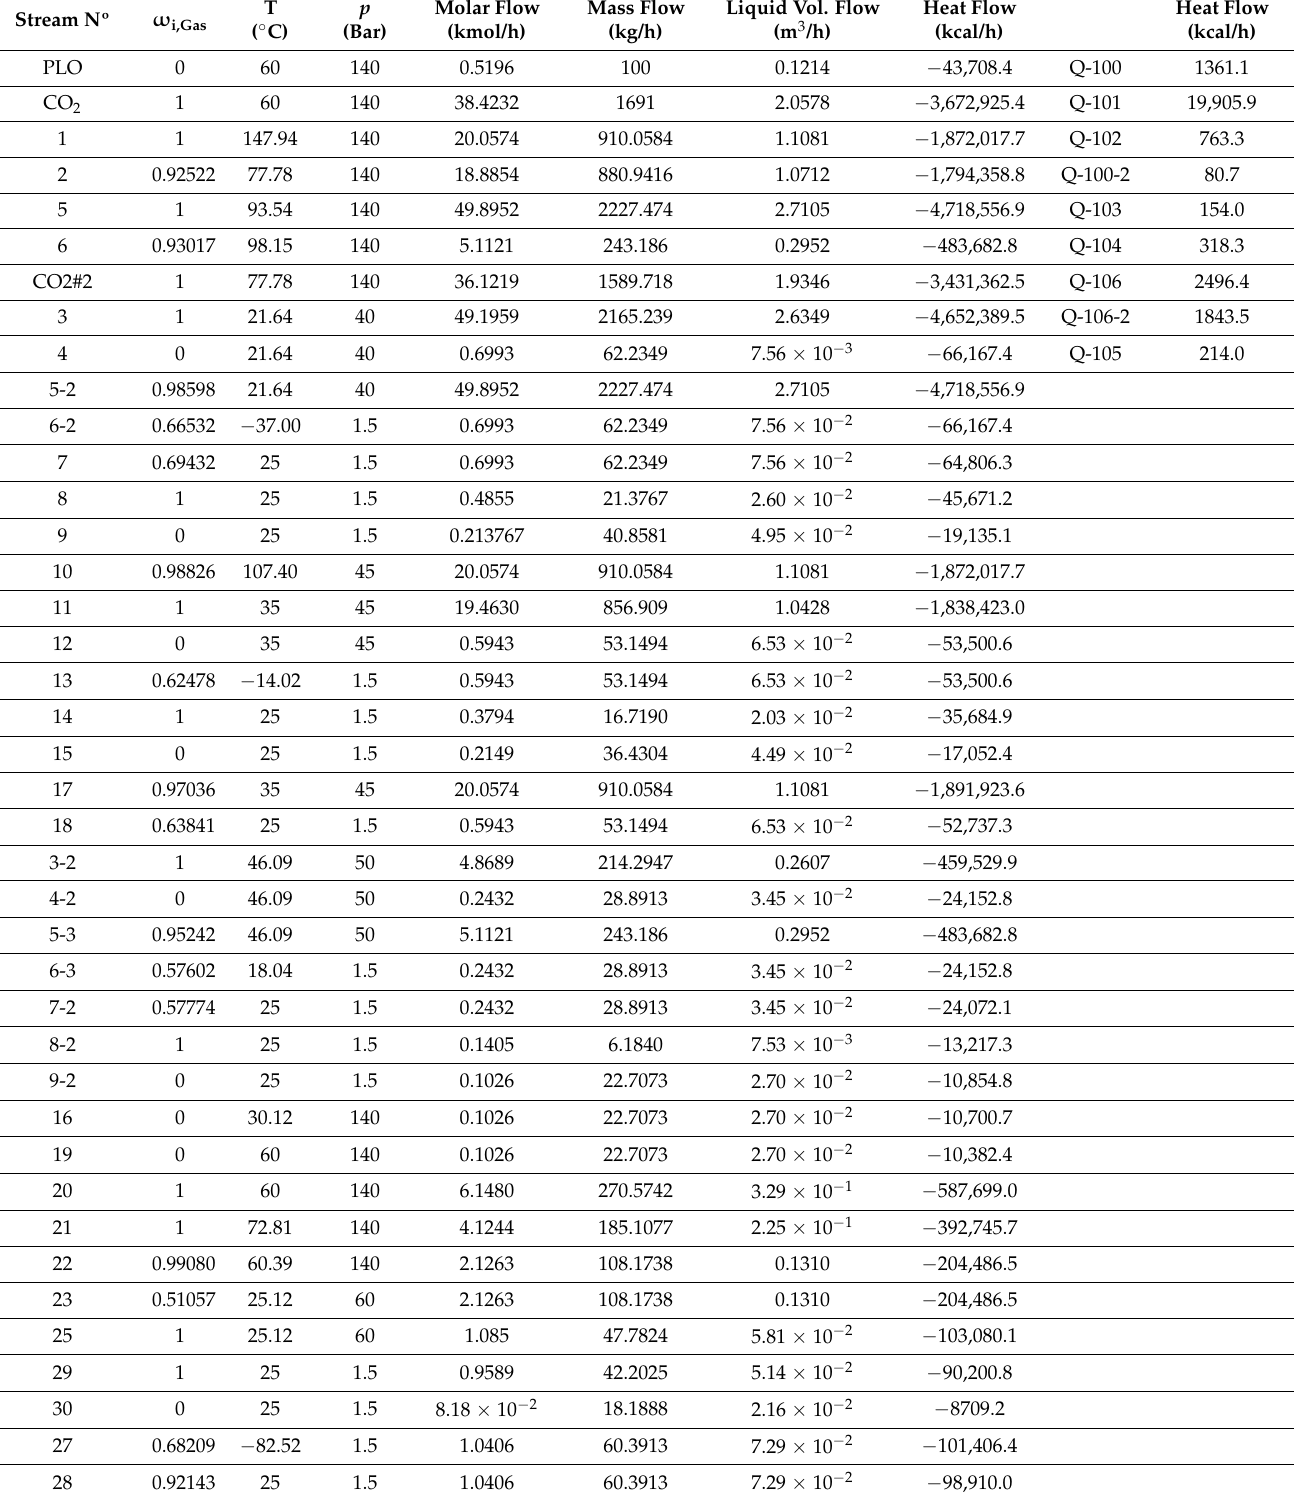
Table 2. Material and energy balances and state conditions (T, P) for all the process streams for the simulation of the OLP deoxygenation process in multistage countercurrent absorber columns using CO 2 as a solvent, with Aspen-HYSYS 8.6 (Aspen One, 2015) as the simulator, expressed on a CO 2 basis, at 333 K, 140 bar, and (S/F) = 17; at 350 K, 140 bar, and (S/F) = 25; and at 333 K, 140 bar, and (S/F) =